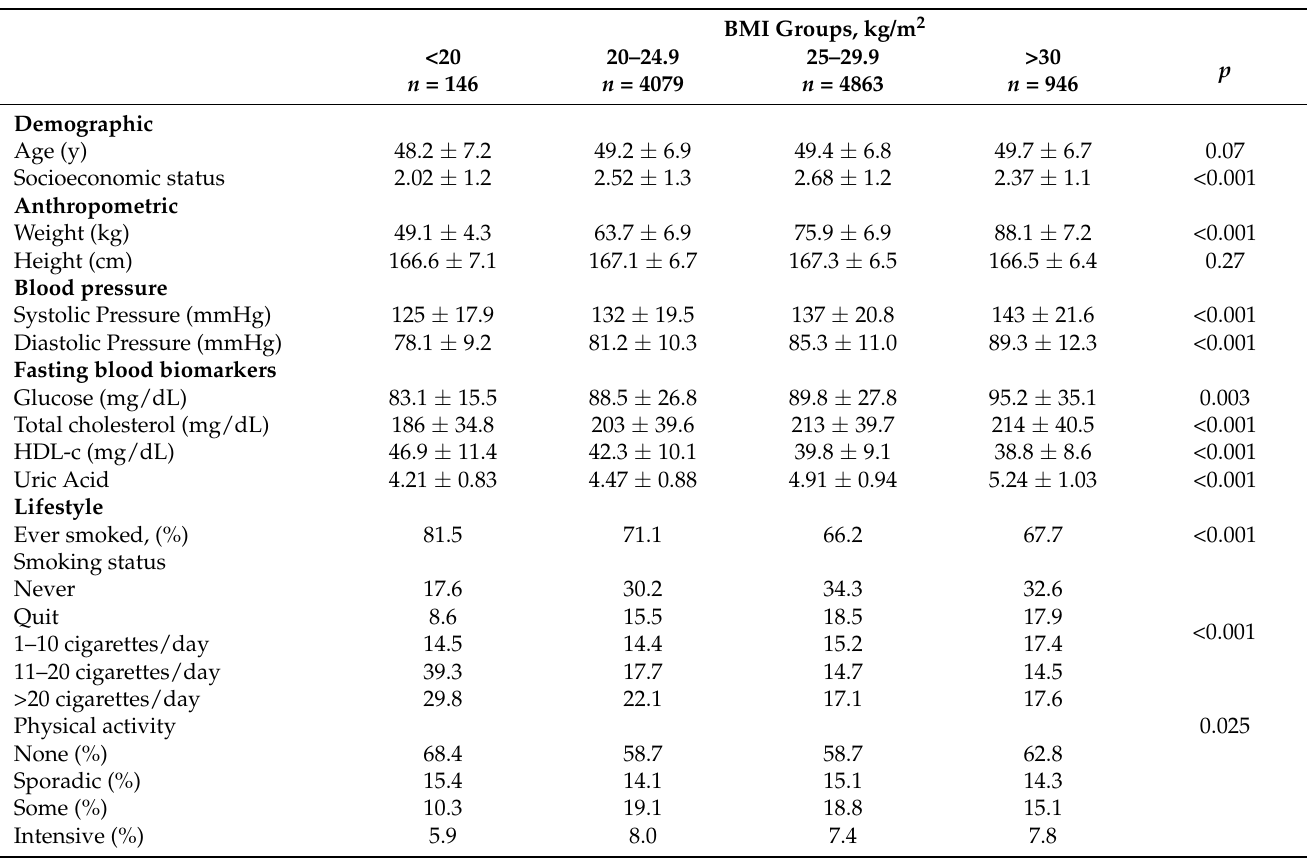
Table 1. Baseline characteristics of the Israeli Ischemic Heart Disease (IIHD) study population by body mass index group, n =